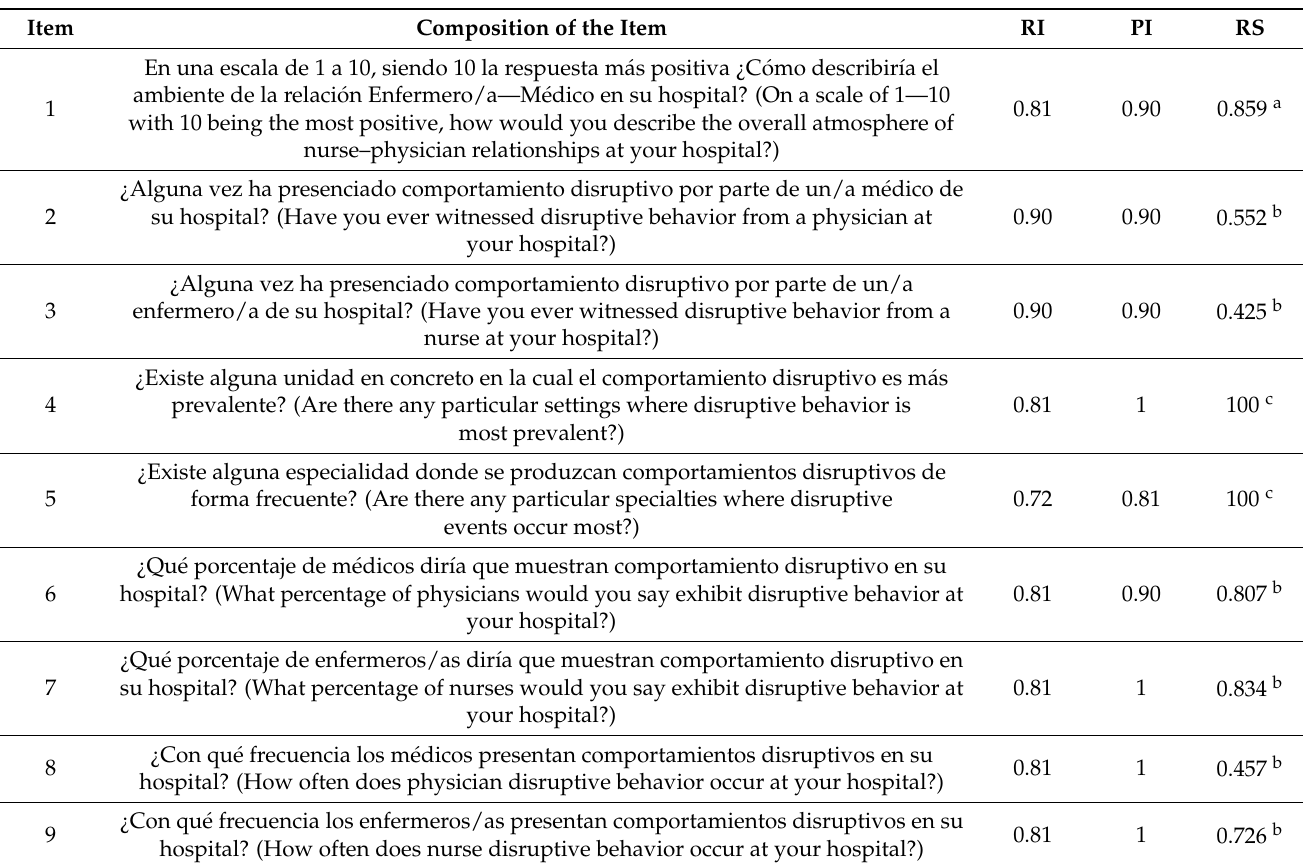
Table 4. Relevance Index (RI) and Pertinence Index (PI) of the items of the